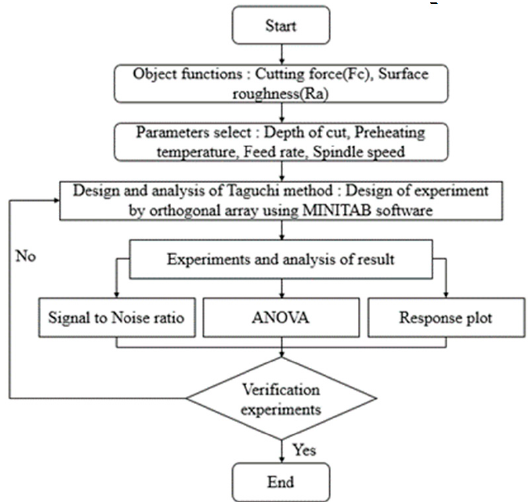
Figure 5. Flow chart of the design of experiments for the laser-assisted machining (LAM) of the C/SiC composite.